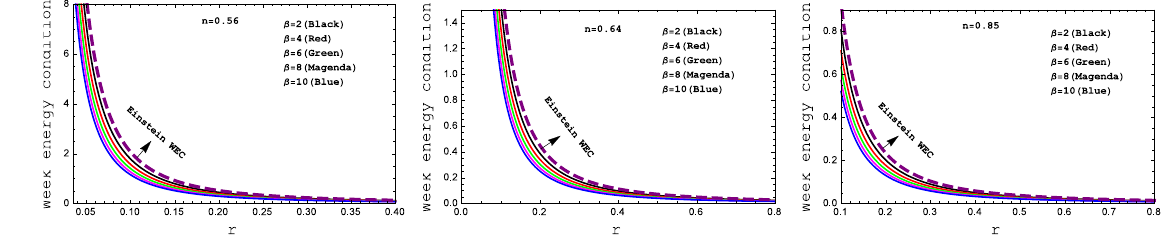
Figure 4. Variation of “ adiabatic index” with respect to the radial coordinate “r” for the compact stars PSR J1614-2230 ( left panel ), Vela X-1 ( middle panel ) and 4U 1538-52 ( right panel ) corresponding to the numerical value of constants A and B from Table 2 and for different values of β .